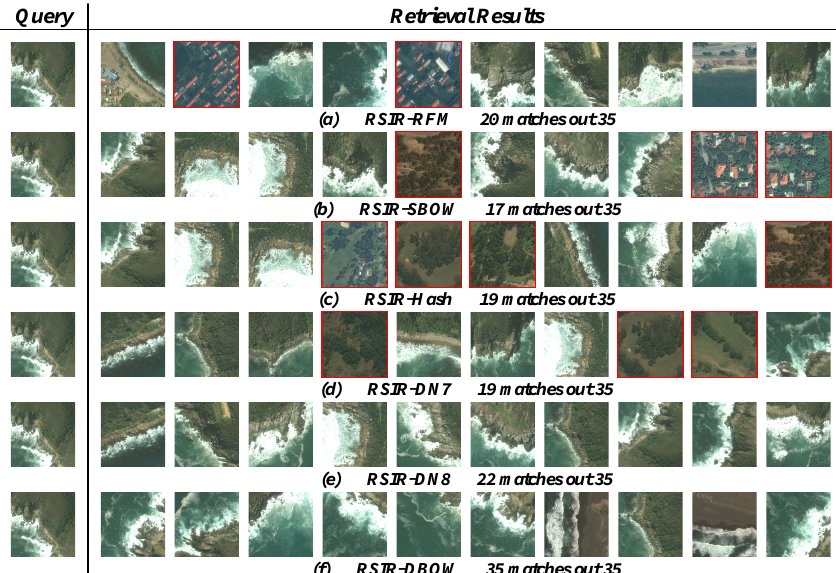
Figure 20. Retrieval examples of “Beach” within ImgDB2 using different RSIR methods. The first images on the left in each row are the queries. The rest of the images in each row are the top 10 retrieval results. The incorrect results are tagged in red, and the number of correct results among the top 35 retrieval images is also